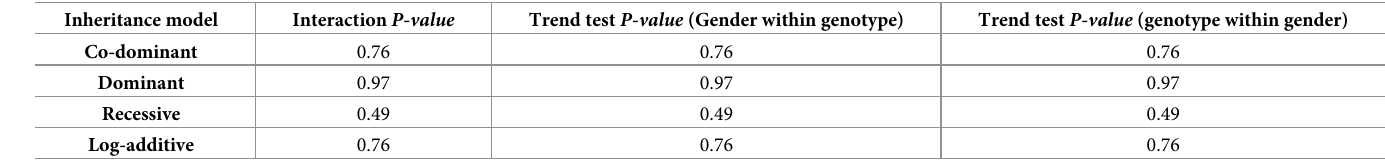
Table 4. Test statistics for interaction between genotypes and gender in determining the COVID-19 severity. Inheritance